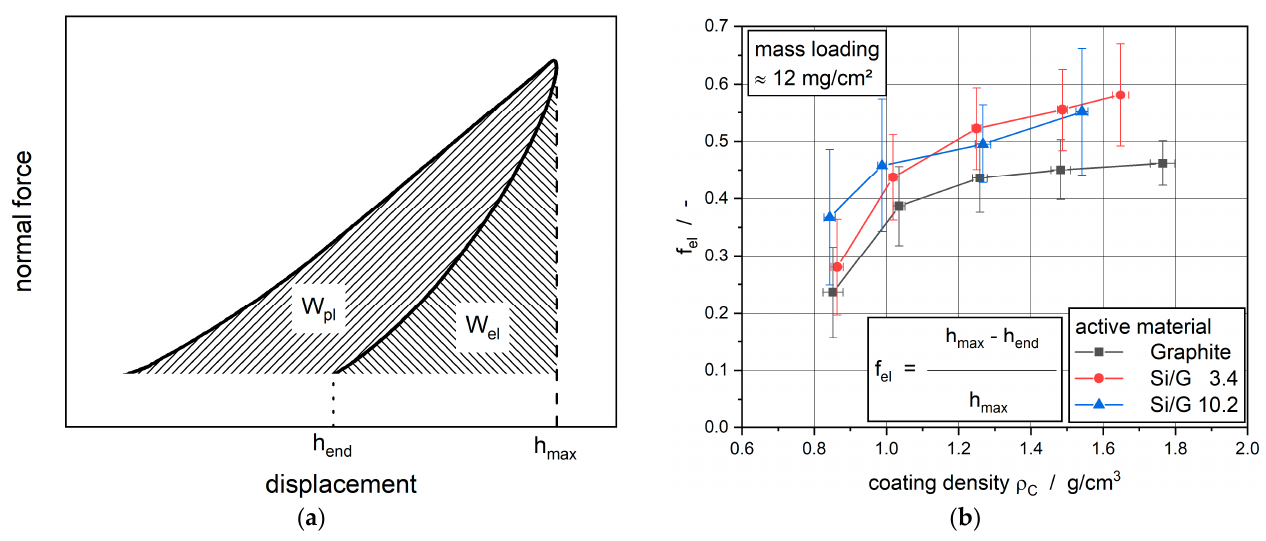
Figure 5. ( a ) Typical normal force and displacement behavior during a nanoindentation measurement; ( b ) factor f el of electrode with different active materials for different coating densities.